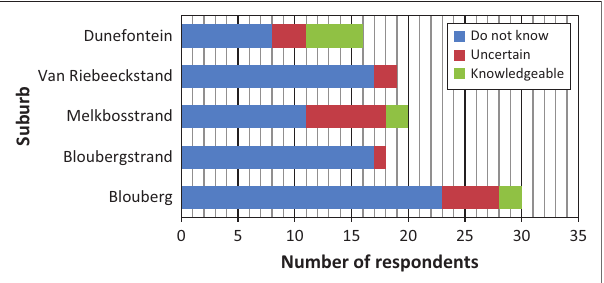
FIGURE 4: Respondents’ knowledge of procedure for evacuating school children.